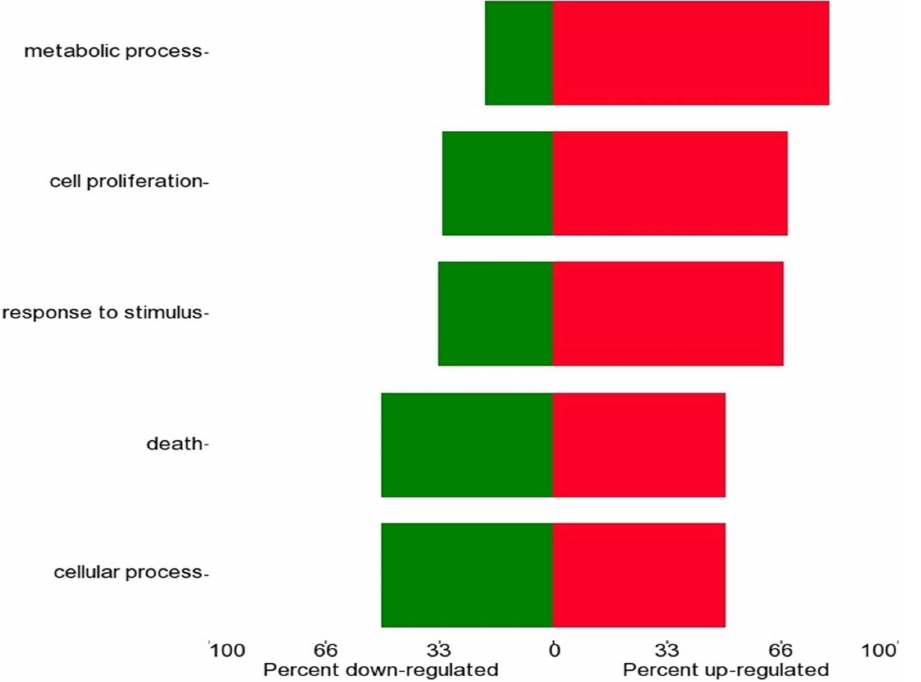
Figure 1. Pathways modulated in chronic HCV. RNA from liver biopsies from 8 HCV patients and normal donor livers were isolated using Trizol reagent and miRNA expression profile in the samples were analyzed using Illumina Bead array. The differentially expressed miRNA identified using Partek analysis were grouped based on the biological pathways that could be modulated. doi:10.1371/journal.pone.0070744.g001 PLOS ONE |